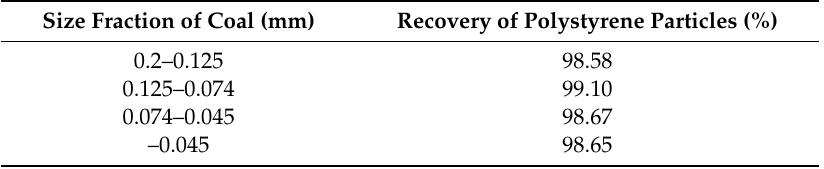
Table 2. Recovery of polystyrene particles after carrier flotation with different coal fractions.